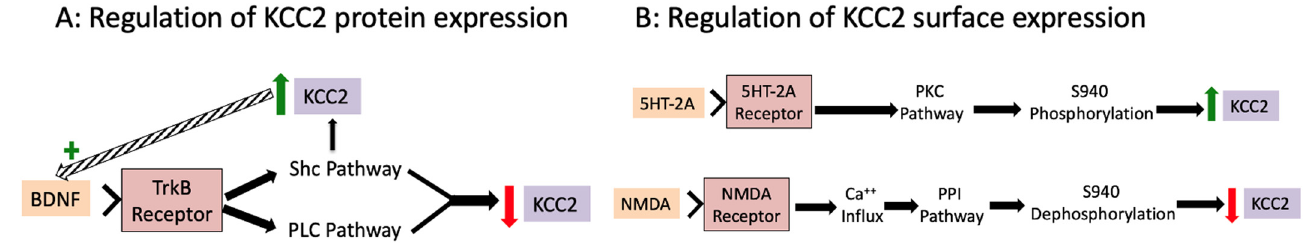
Figure 4. This figure highlights several key cellular mechanisms that regulate KCC2 function. While the complexity of regulating the key players of ionic plasticity (KCC2 and NKCC1) is yet to be fully elucidated, we highlight here key concepts relevant to the current review. ( A ) Regulation of KCC2 protein expression. Figure depicting the pathways by which BDNF regulates KCC2 protein expression. ( B ) Regulation of KCC2 surface expression. Figure depicting two known signaling pathways that regulate KCC2 surface expression and stability by means of altering the phosphorylation state of KCC2. Adapted, in part, from: [30].